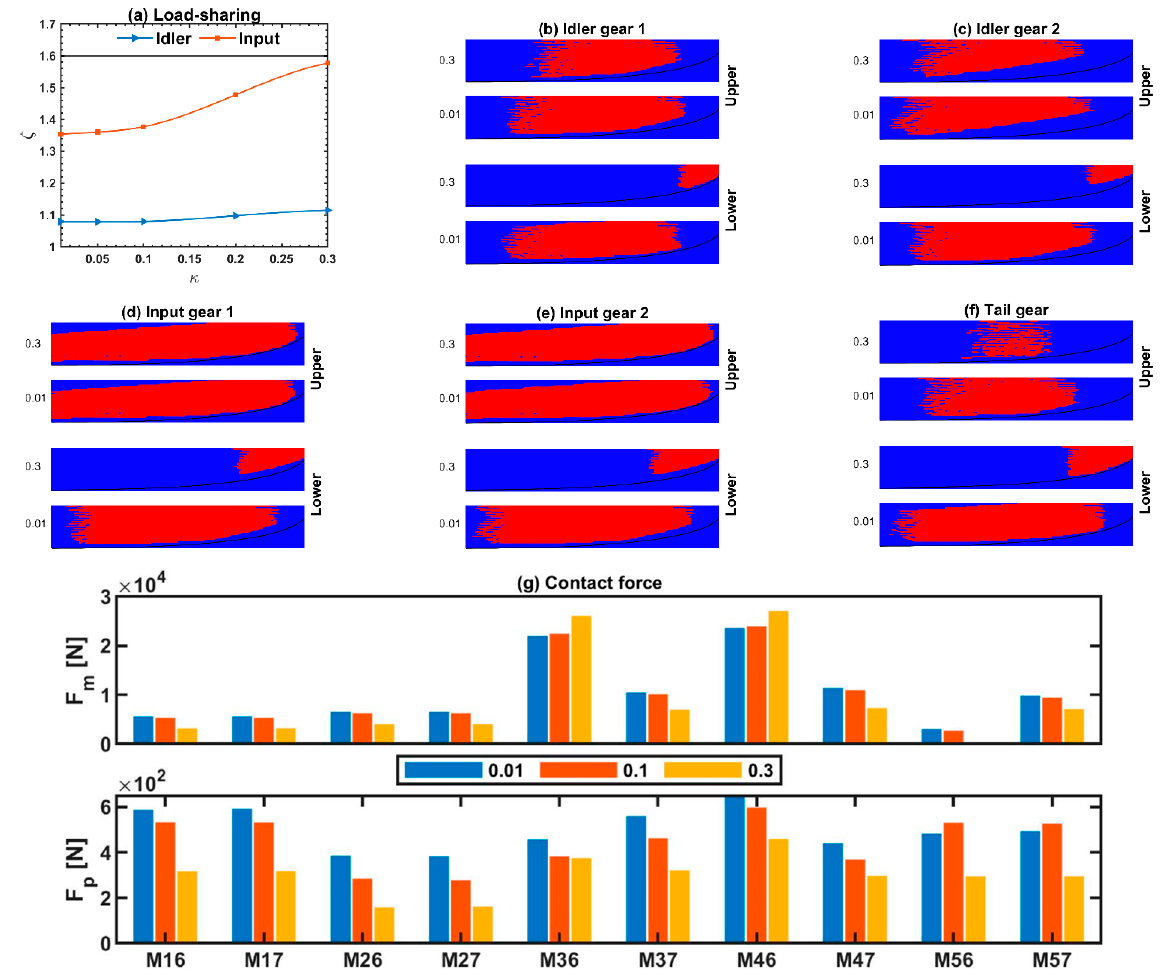
Figure 17. Influence of the axial installation error of the lower face gear on the load-sharing and contact characteristics.